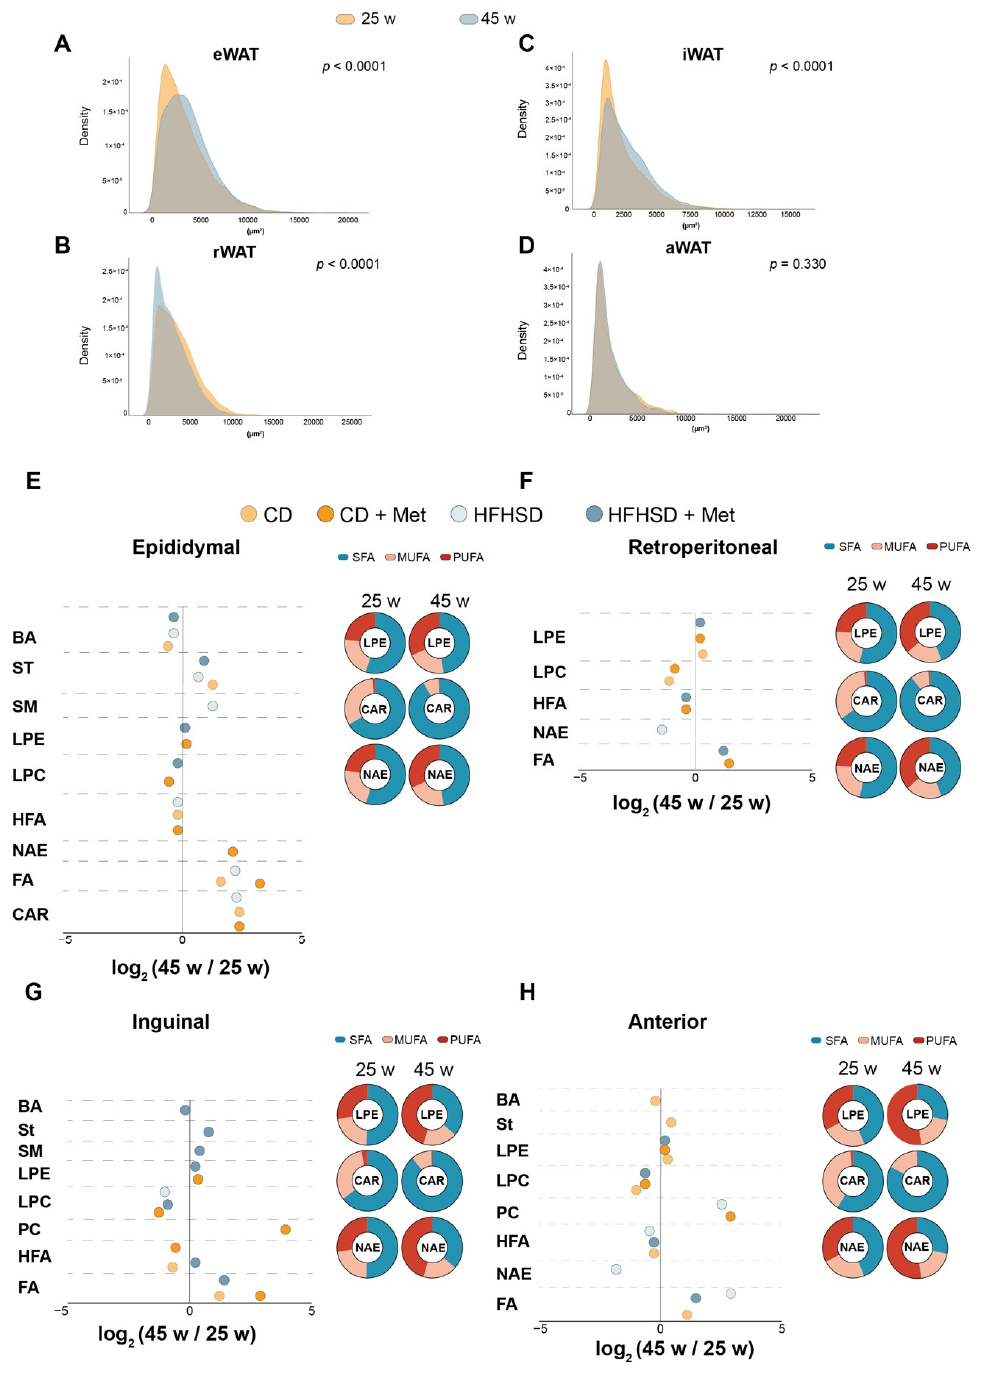
and metformin administration; ( D – H ) Lollipop plots showing the age of mice in sky-blue dots (25 w) and blue dots (45 w). Horizontal axis displays the mean relative abundance of lipids, while the vertical axis reflects the group of mice ( n = 4/group) p values < 0.05 are considered significant. (Wilcoxon-rank sum test). CD: chow diet; HFHSD: high-fat high-sucrose diet; Met: metformin; w: weeks.